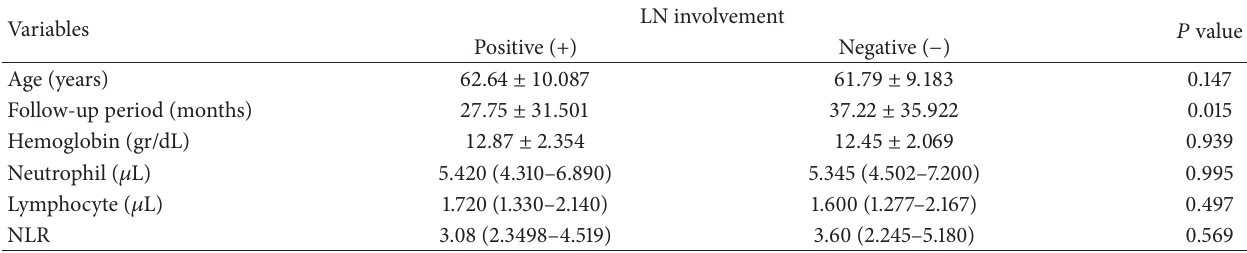
Table 3: Variables according to LN